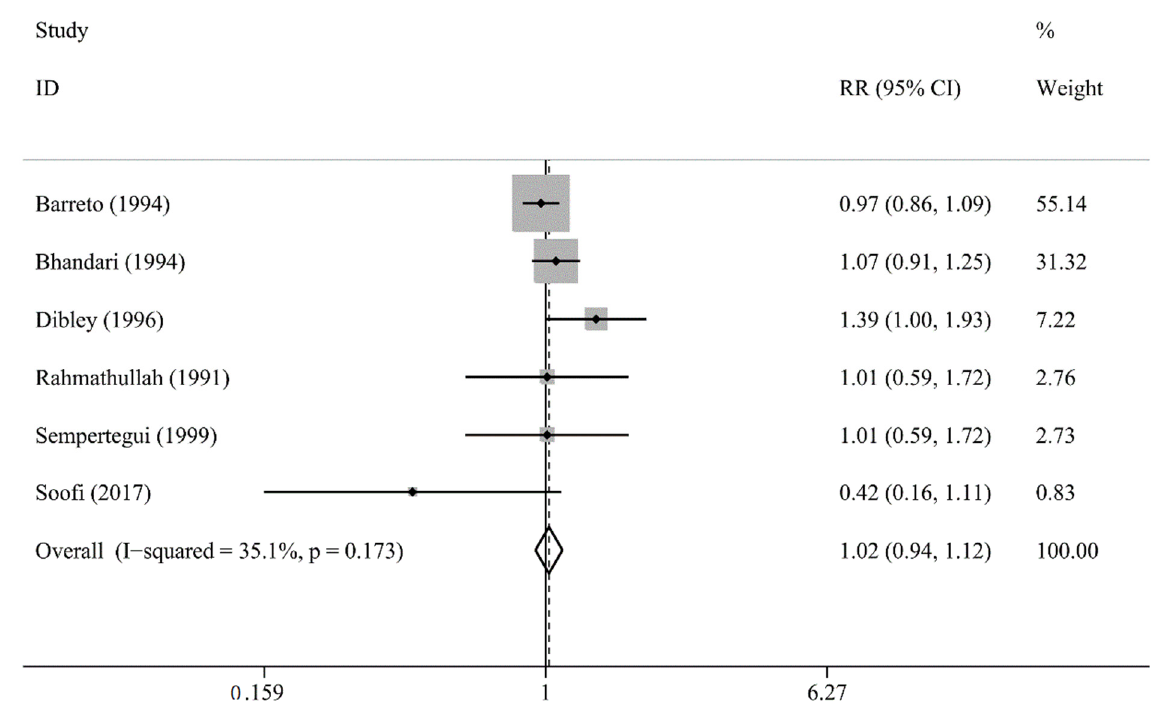
Figure 4. Comparison of Vitamin A versus Control, Outcome 6—Lower respiratory tract infection (LRTI) incidence at longest follow-up; RR: risk ratios or rate ratios.